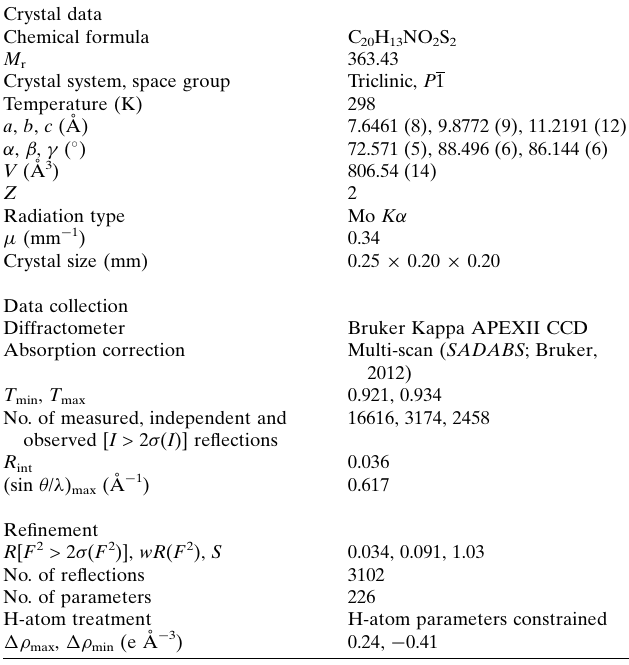
Crystal data Chemical